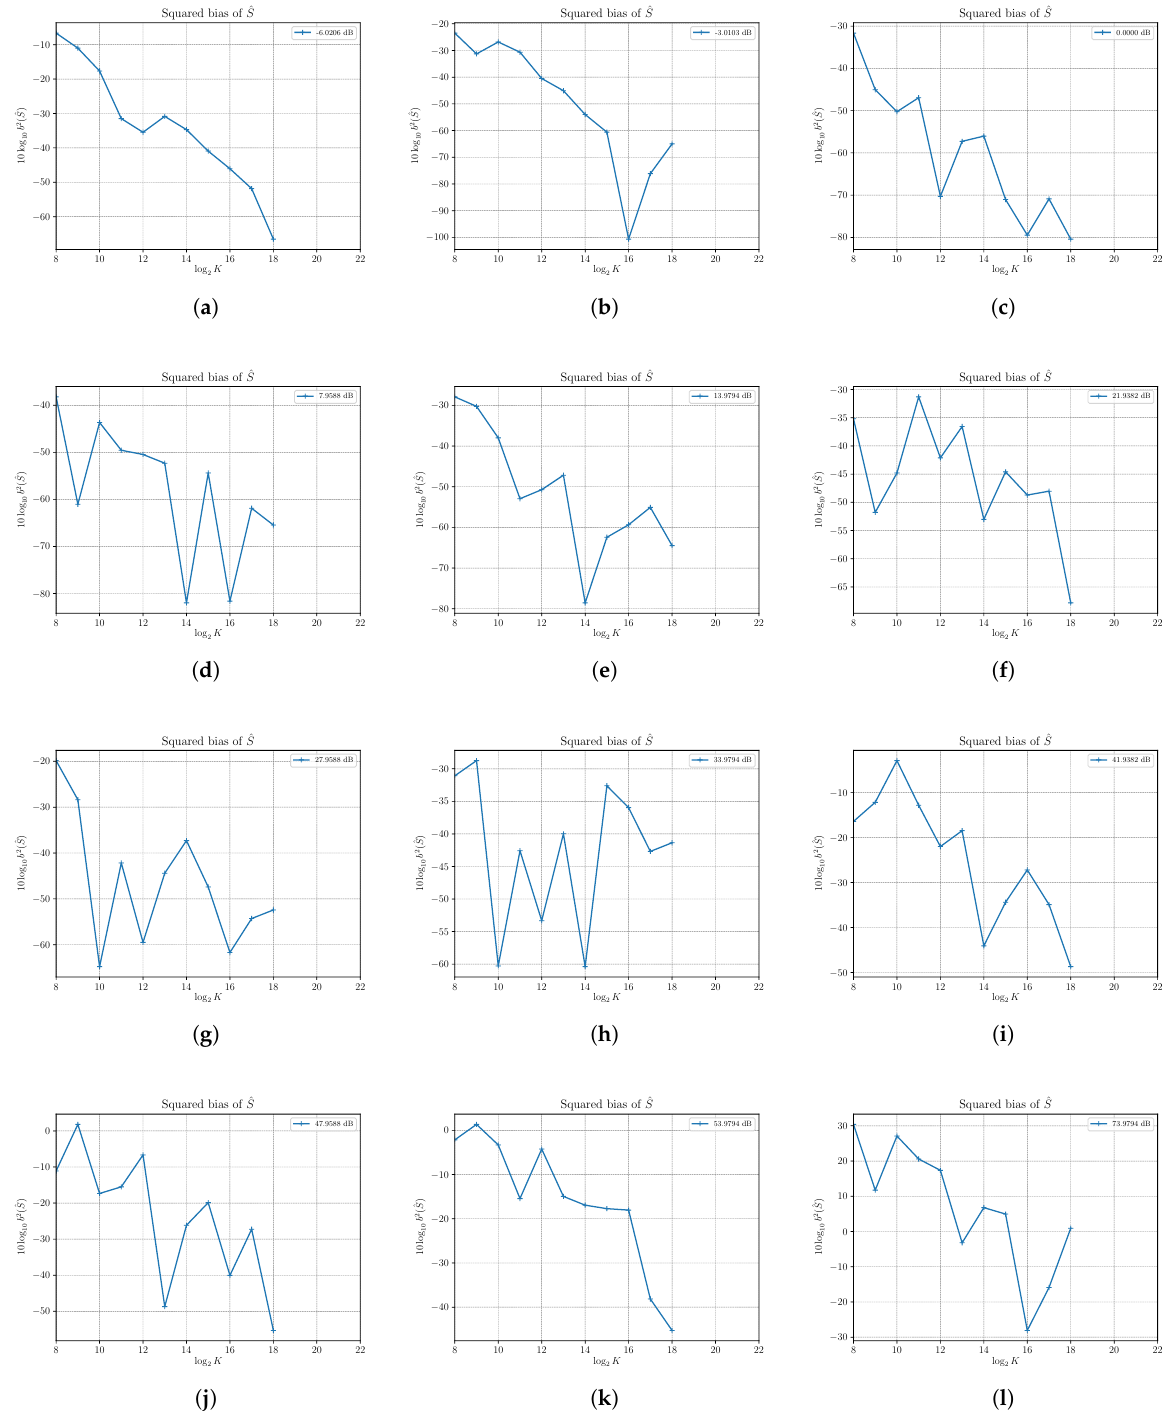
Figure 3. The estimated squared bias b 2 ( ˆ S ) of signal power estimator ˆ S versus the number of observations K . Each sub figure ( a – l ) shows results for a given nominal value of SNR obtained by changing the signal power S and with noise power N =